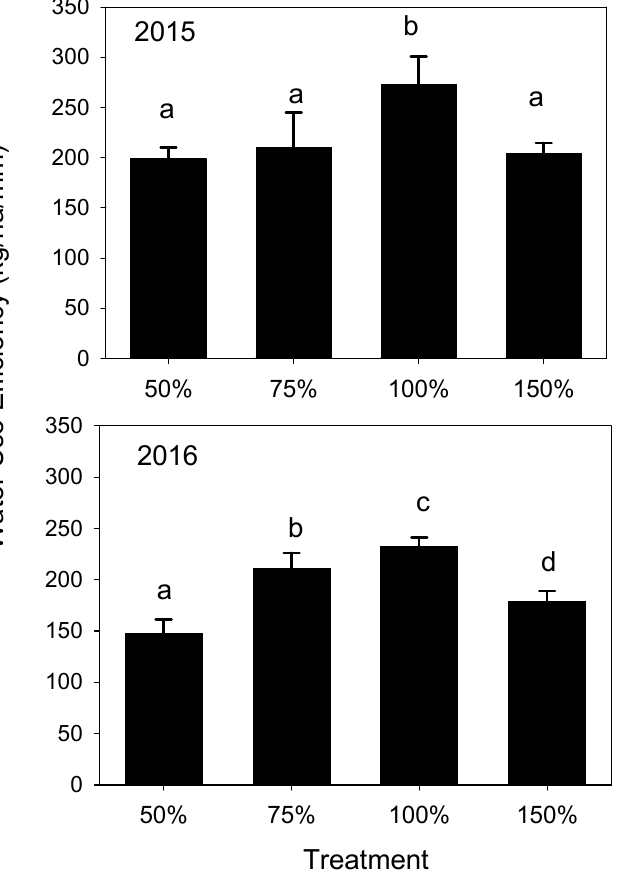
Figure 4. Water use efficiency of irrigation treatments for both trials, based on carton yields. Treatments are 50–150% of crop water requirement. Treatment means with different letters (a–d) are statistically different at the p < 0.05 confidence level. Error bars represent standard deviations of treatment means.